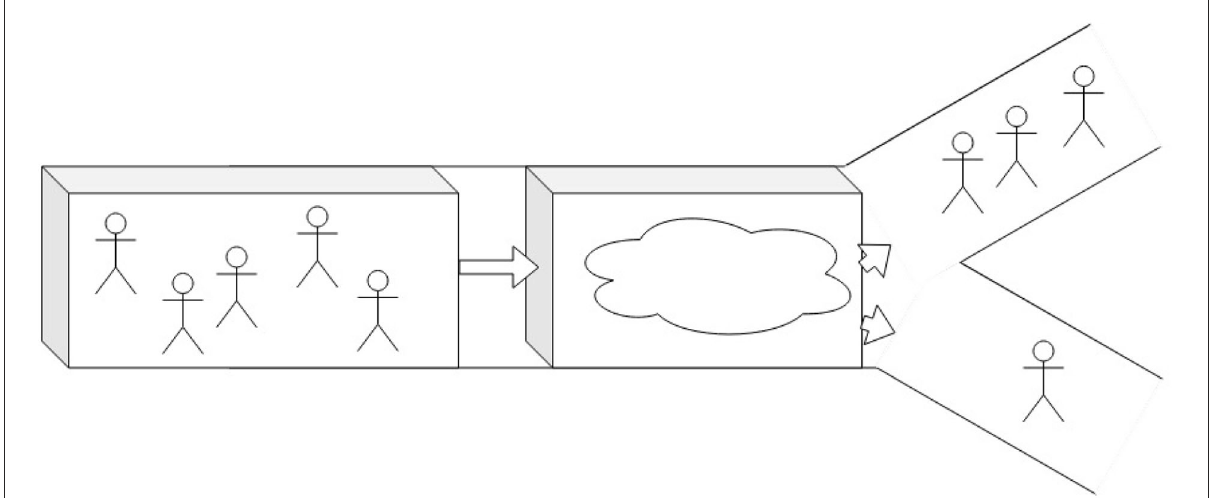
FIGURE7 Example of the Collaboration pattern allowing to simulate the example agent-based evacuation model than relying on a fluid model simulating the crowd as a fluid to process the number of agents going to one exit or another. Those models are processed independently and are considered by each other as black